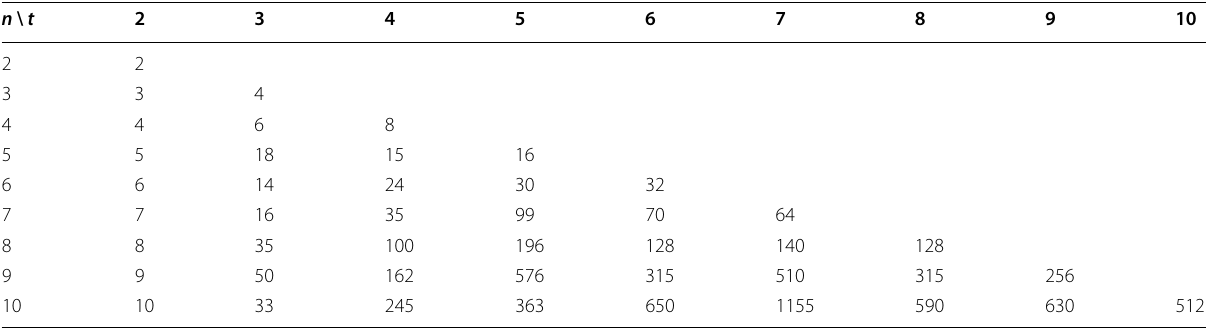
Table 1 Minimum e x to achieve maximum α